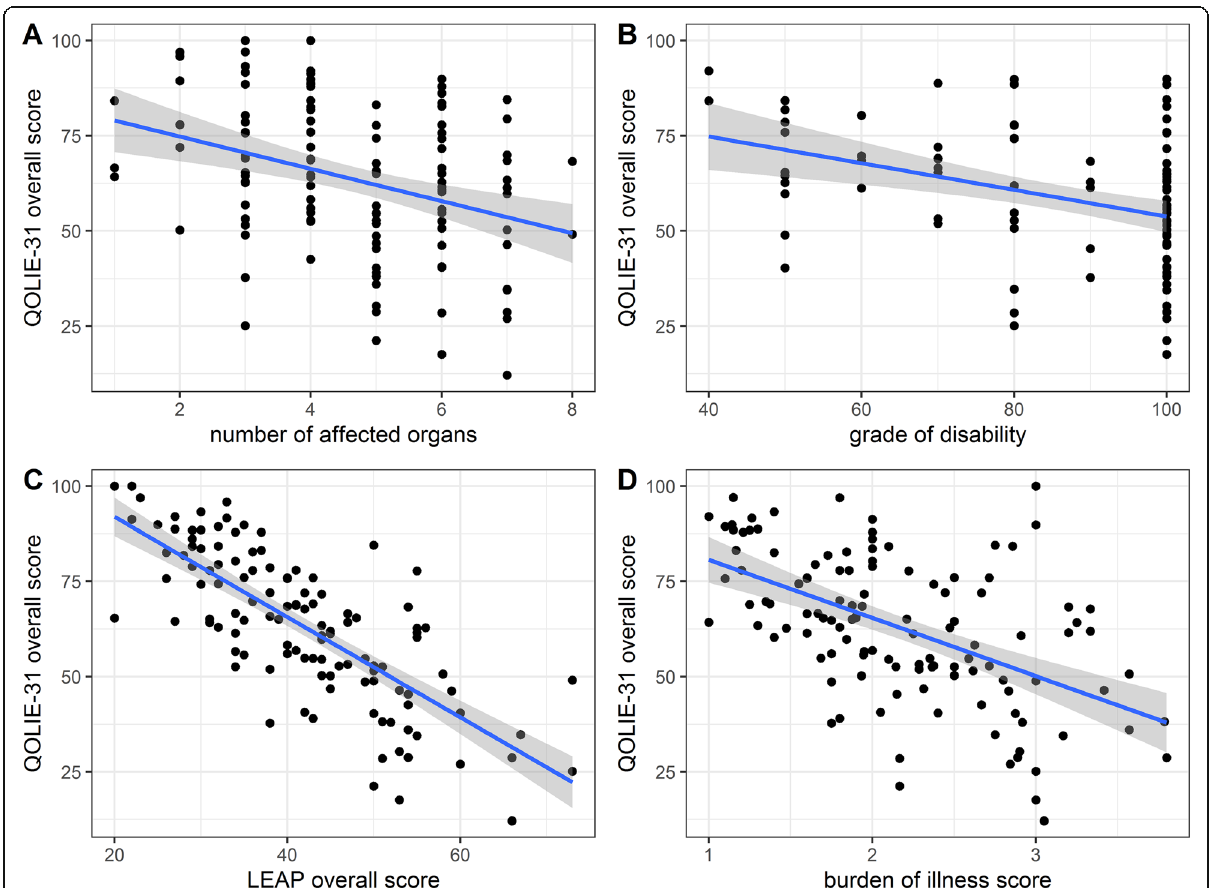
Fig. 1 Correlation between health-related quality of life and other factors in TSC. Health-related quality of life (HRQoL) in adult individuals with tuberous sclerosis complex (TSC), as assessed by the Quality of Life in Epilepsy Inventory-31 items (QOLIE-31) overall score was significantly correlated with A ) the number of affected organ systems, B ) the grade of disability, and C ) the overall Liverpool Adverse Events Profile (LAEP) score, which measures therapy-related adverse events. D : HRQoL in adults with TSC was also significantly correlated with the perceived burden of illness, which was calculated as an index of 20 possible TSC-associated problems (possible range of 0 – 4 for each